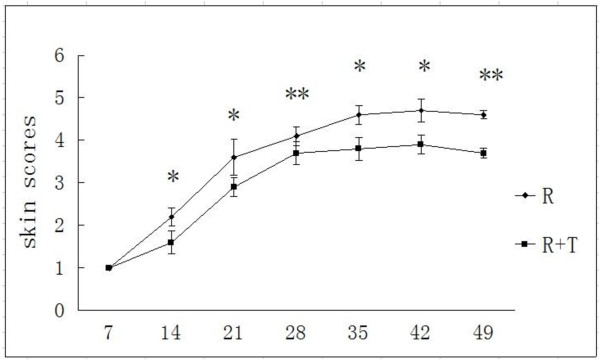
Skin scores in different time-points. The time courses of the skin scores after 45Gy of irradiation. All dates are presented as mean ± SD in 5 rats. *P < 0.05, **P < 0.01.